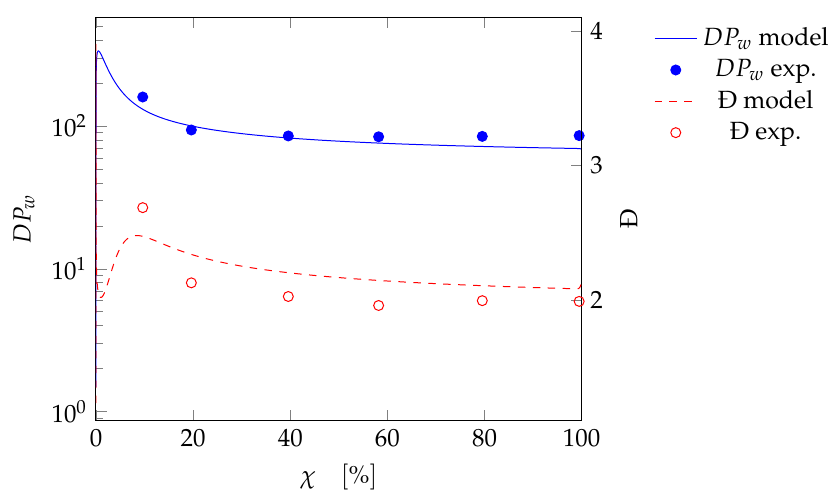
Figure 4. Fitting test SBR4: weight-average degree of polymerization ( DP w ) and polydispersity (Ð) as a function of the monomer overall conversion. Curves: model results; symbols: experimental